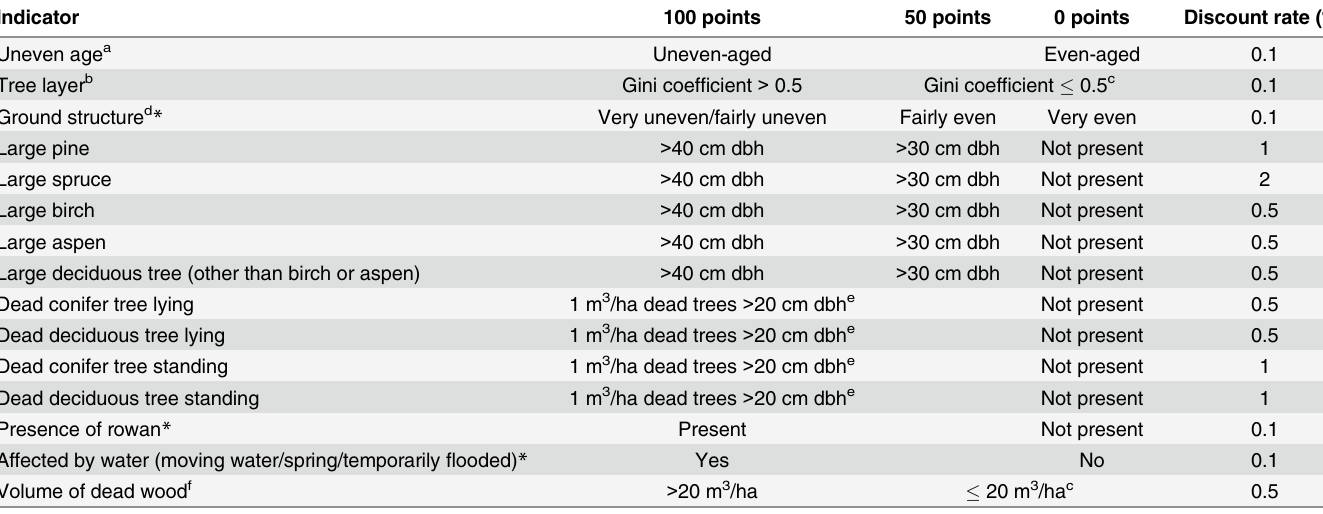
Table 1. List of forest structural indicators, criteria for points, and the discount rate used in the discount function 3 (see Material and